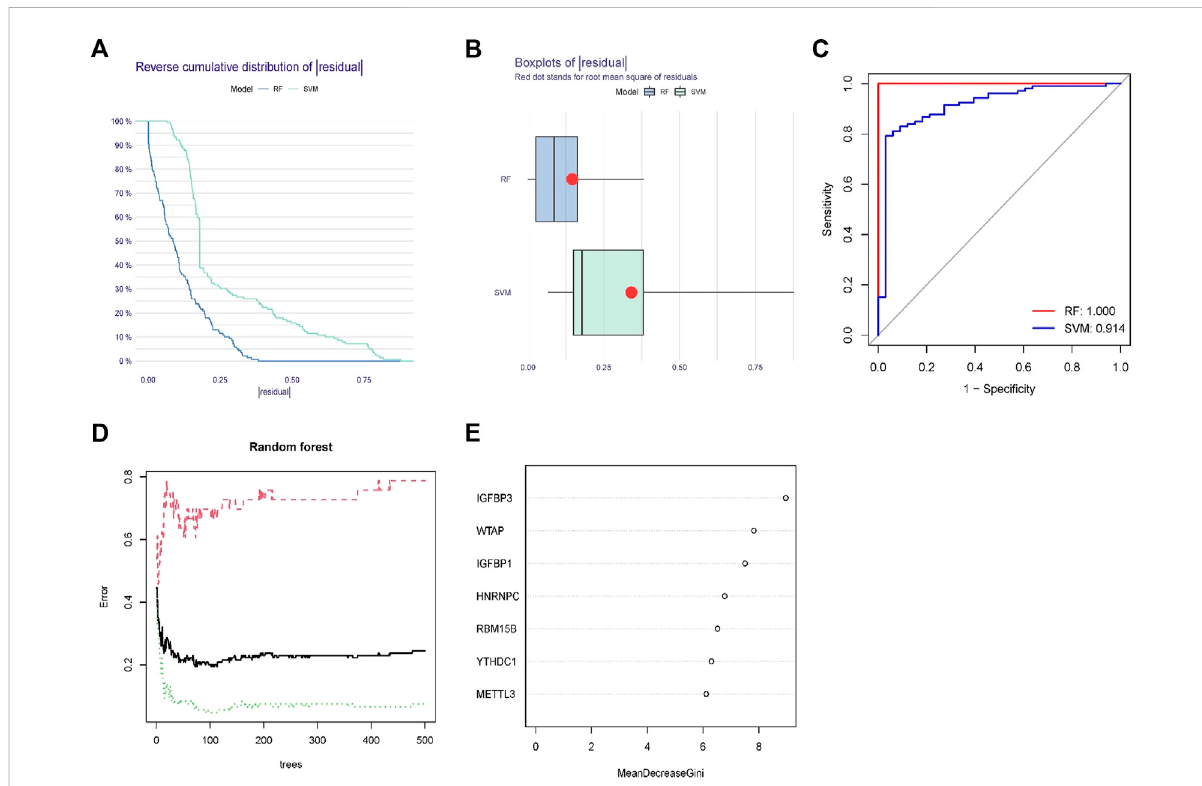
FIGURE 4 Random forest(RF) model and support vector machine model. (A) The residual distributionof theRFand support vector machine (SVM)models was displayed using the reverse cumulative distribution of residuals. (B) The residual distribution of the RF and SVM models was displayed using boxplots of residuals. (C) The receiver operating characteristic curves showed how accurate the RF and SVM models were. (D) The tree model demonstrates that the error has stabilized. (E) The seven m 6 A regulators ’ relative